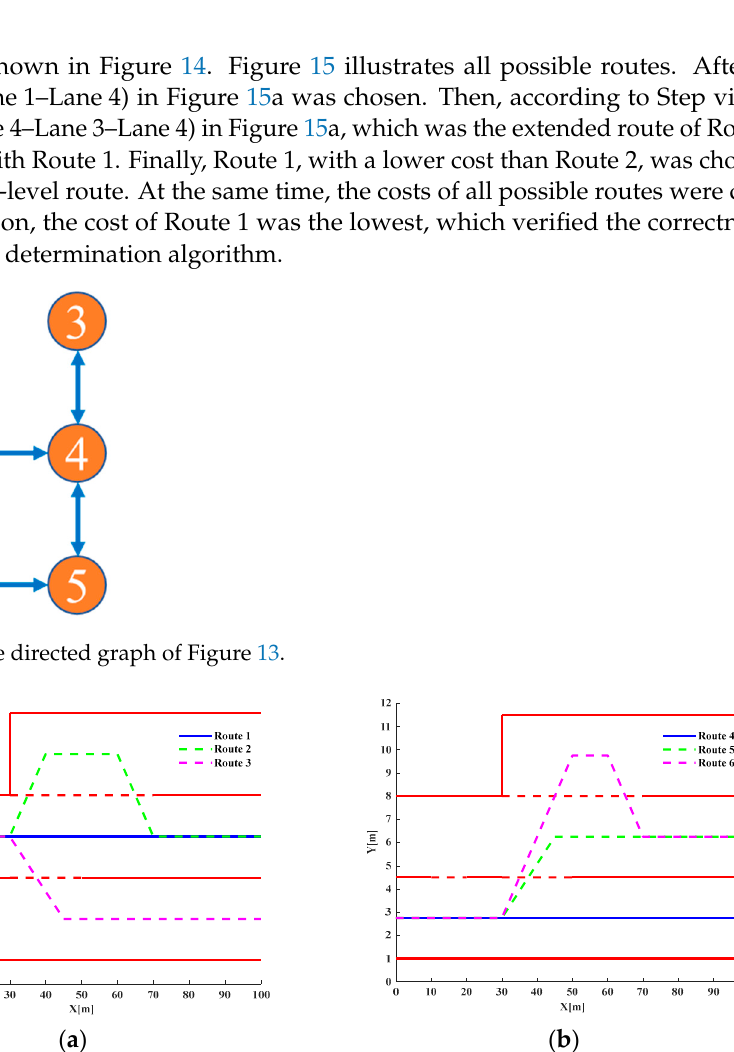
Figure 15. ( a ). Three possible routes with Lane 1 as the start lane. ( b ). Three possible routes with Lane 2 as the start lane.